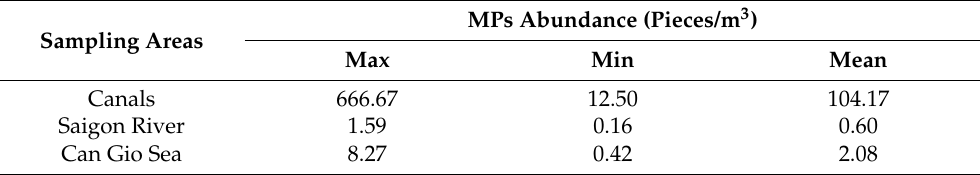
Table 1. Mean abundance of MPs in canal systems, Saigon River, and Can Gio Sea. Sampling